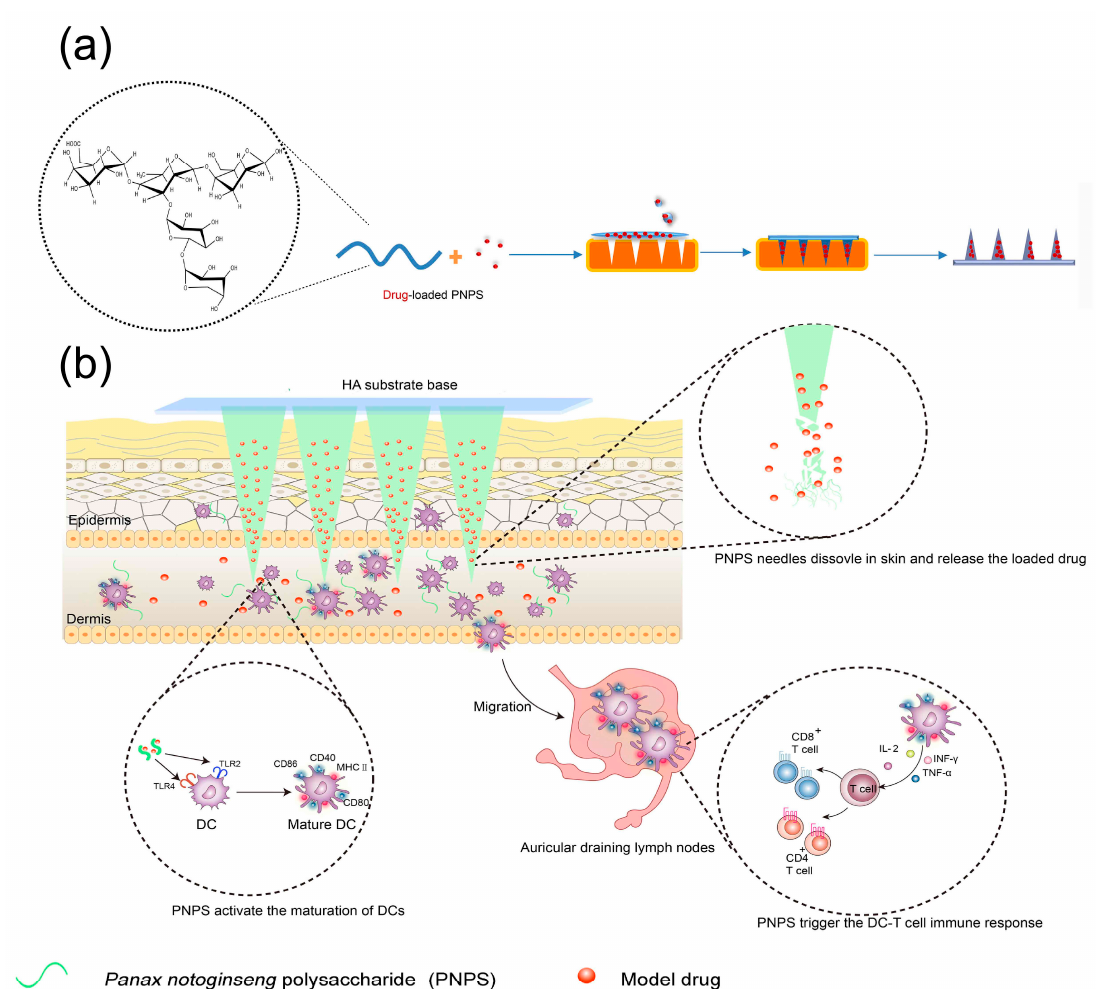
Figure 11. Schematic diagram of the preparation of the dissolved Panax notoginseng polysaccharides MN (PNPS MNs) and in vivo activation process. ( a ) The preparation process of PNPS MNs loaded with the model drugs. ( b ) PNPS MNs dissolved and activated skin dendritic cells and triggered DC- initiated T cell immune response for transcutaneous immunization [99]. Reproduced with permission from Chengxiao Wang, Carbohydrate Polymers; published by Elsevier,